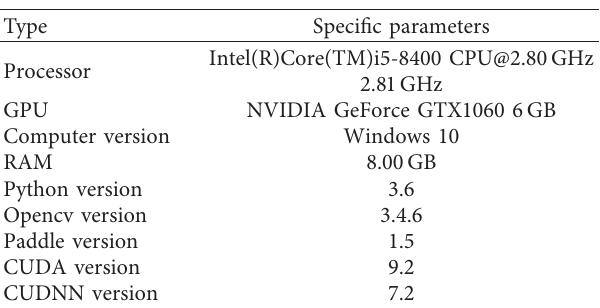
Figure 11: Driver fatigue state assessment model flow chart. Table 1: Hardware configuration